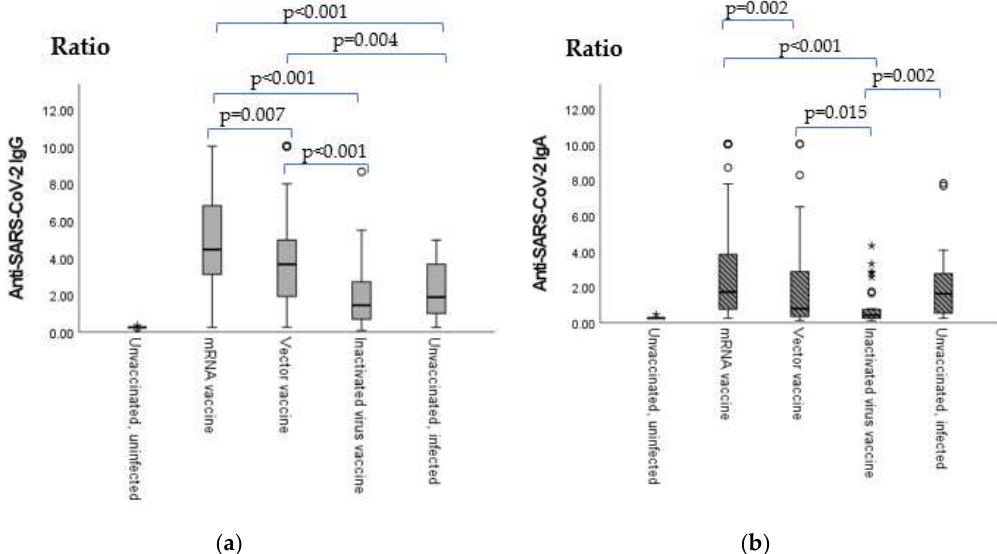
Figure 1. Anti-SARS-CoV-2 IgA and IgG antibody titer results are expressed as a ratio of the extinction of the patient sample (or control) over the extinction of the calibrator. Ratio < 0.8—negative; ratio ≥ 0.8 to 1.1—borderline; and ratio > 1.1—positive. ( a ) Vaccination group-based comparison of anti-SARS-CoV-2 IgG titers. ( b ) Vaccination group-based comparison of anti-SARS-CoV-2 IgA titers. Sample numbers: mRNA vaccine (Pfizer–BioNtech) = 106, vector vaccine (AstraZeneca and Sputnik V) = 77, inactivated virus vaccine (Sinopharm) = 34, unvaccinated, uninfected individuals (used as the negative control) = 9, and unvaccinated, infected individuals (used as the positive control) = 27. Total = 255.